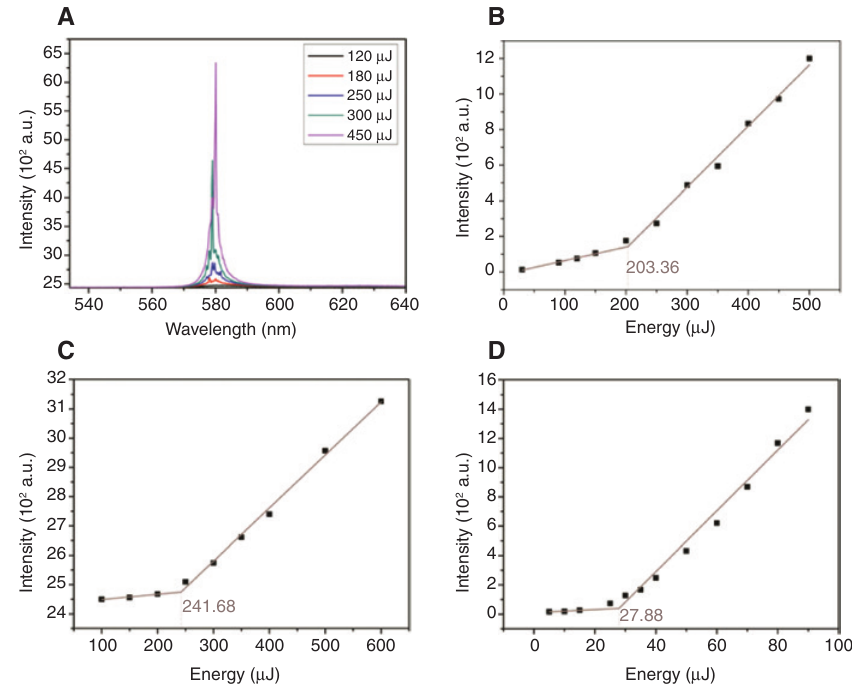
Figure 6: Random laser properties observed in the polymer films using semi-polymerization coating method. Emission spectra of LOPP (A) with different pumping energy; integrated emission intensity and corresponding FWHM as function of pumping energy for LOPP (B), LOCP (C) and LOPM